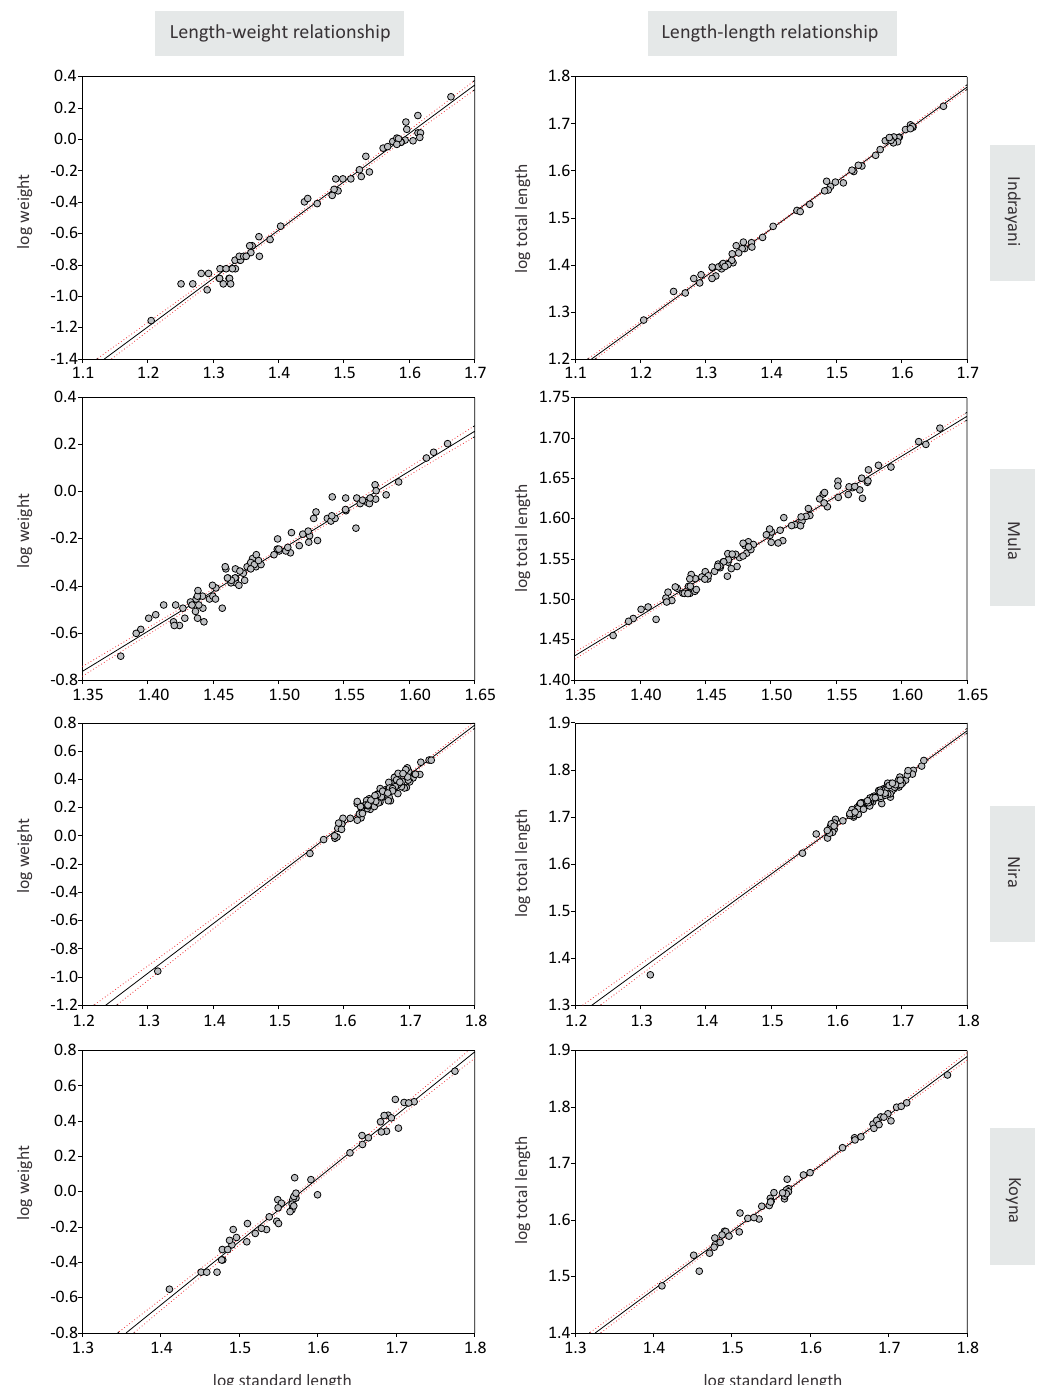
Appendix C. Scatter plots for Paracanthocobitis mooreh . Dashed lines are 95% confidence intervals for the regression